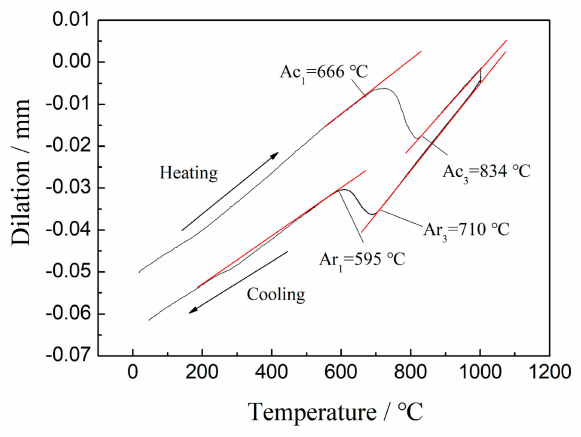
Figure 2. Dilation curves recorded during heating of the experimental